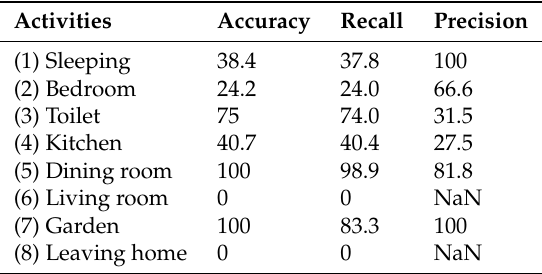
Table 3. Accuracy, recall, and precision for each activity obtained based on FFSM.